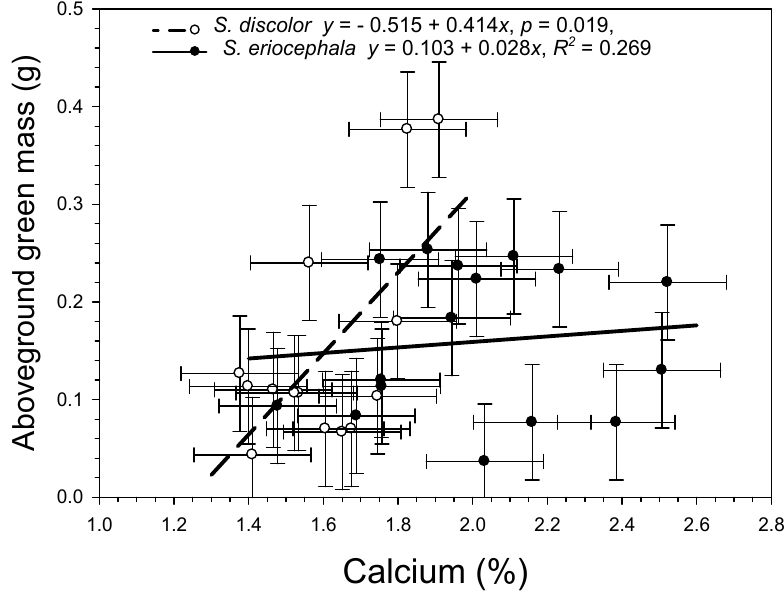
Figure 8. Covariate analysis of green mass vs. calcium concentration for Salix discolor and S. eriocephala